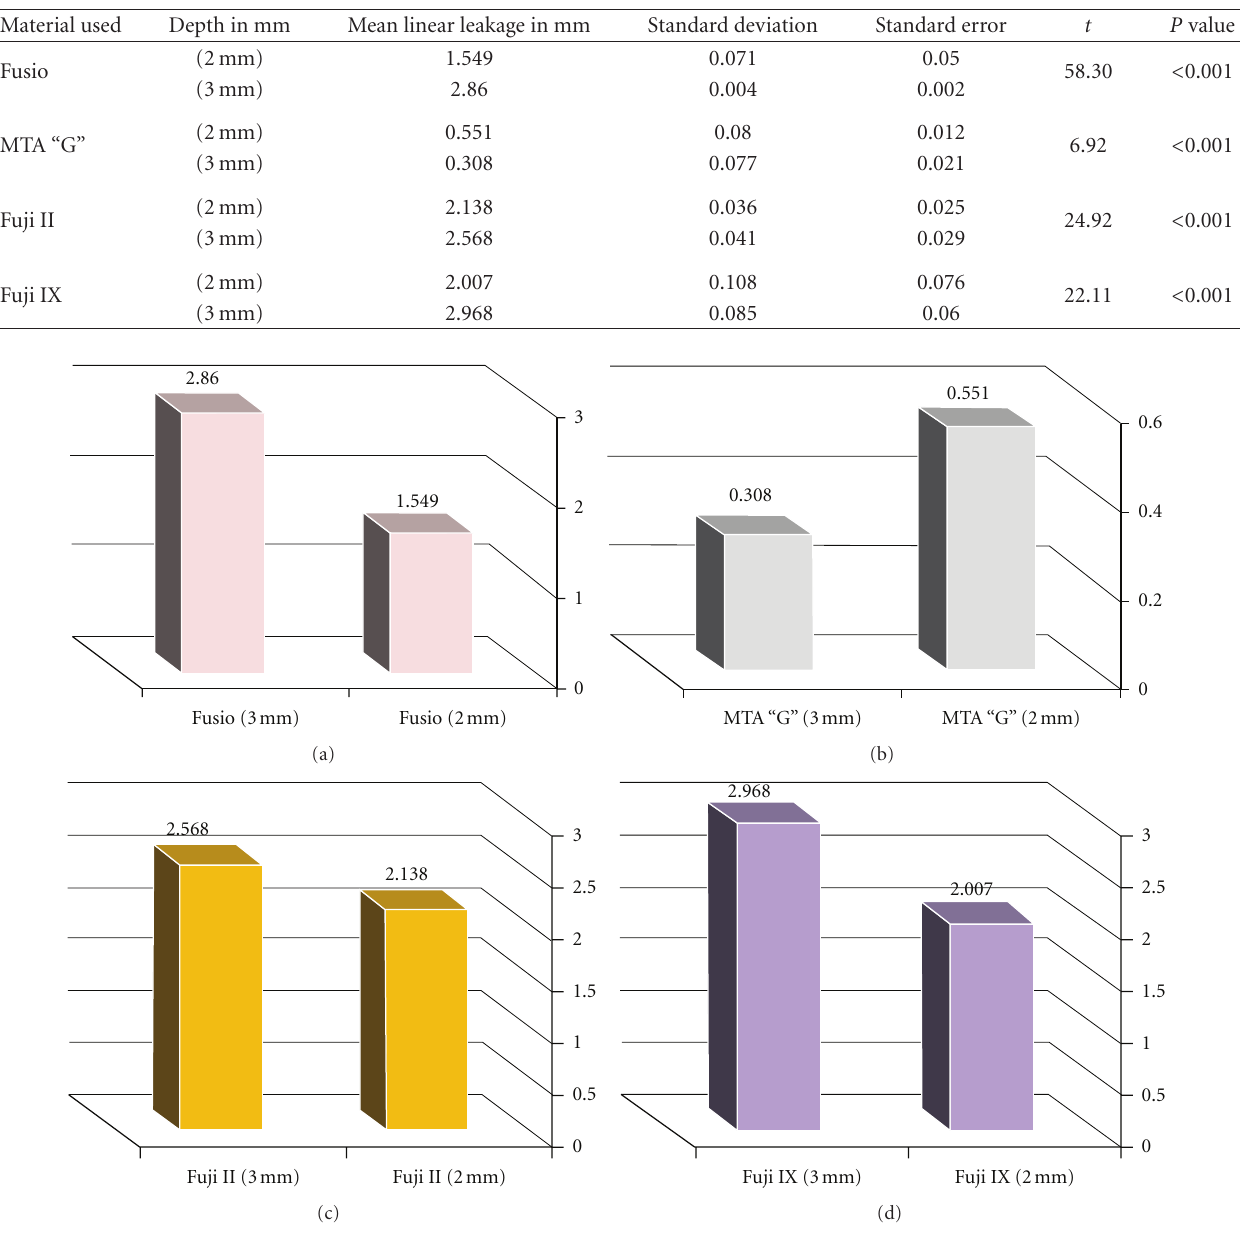
Figure 1: Comparison between linear leakage score in mm for Fusio (a), MTA “G” (b), Fuji II (c), and Fuji IX (d) tested material at 3mm and 2mm orifice depths.